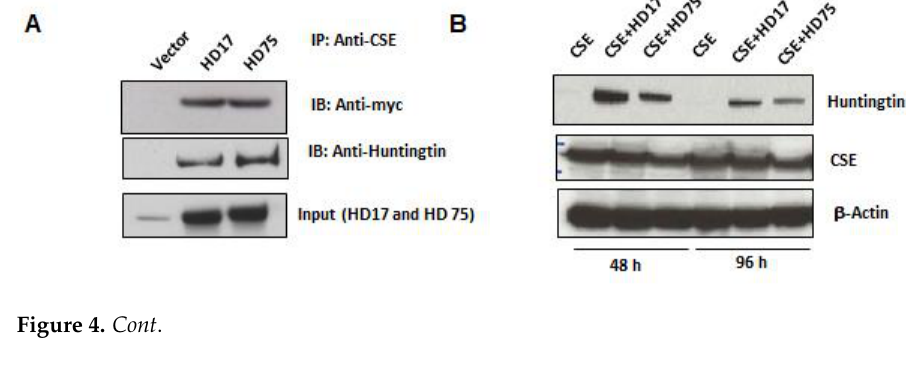
Figure 4. Mutant huntingtin (mHtt) binds cystathionine g-lyase (CSE) and inhibits its catalytic ac- tivity. ( A ) Interaction of CSE with huntingtin. HEK293 cells were transfected with constructs encod- ing myc-tagged CSE and either HD17 or HD75 for 24 h and immunoprecipitation conducted using anti-myc antibody. CSE bound both wild-type and mutant Htt. ( B ) Expressions of CSE, WTHtt, and mHtt at 48 and 96 h post-transfection as determined by Western blotting. ( C , D ) Activity of CSE at 48 and 96 h, respectively, as measured by assaying H 2 S production from 10 mM L-cysteine in the presence of the cofactor, pyridoxal 5-phosphate (PLP at 250 mM), using the methylene blue assay. ( E , F ) Enzymatic activity of CSE at 48 and 96 h respectively, as measured by assaying cysteine pro- duction from cystathionine in the presence of the cofactor, pyridoxal 5-phosphate (PLP at 250 mM), using the ninhydrin assay. n = 3, SEM, * ** p < 0.001. 4. Discussion The principal finding of this study is that the transsulfuration pathway, which plays central roles in neuroprotective processes, is disrupted at multiple levels in HD. Our prior studies have identified a major decrease in CSE levels in human HD brains, in the brains of R6/2 HD mice, and in Q111 striatal cell lines, which are associated with impaired stress responses [9,11,13]. Additionally, other groups have reported a suboptimal expression and activity of the transporters for cystine and cysteine, respectively [15,34]. We have also shown that cysteine homeostasis is linked to stress responses such as the oxidative stress